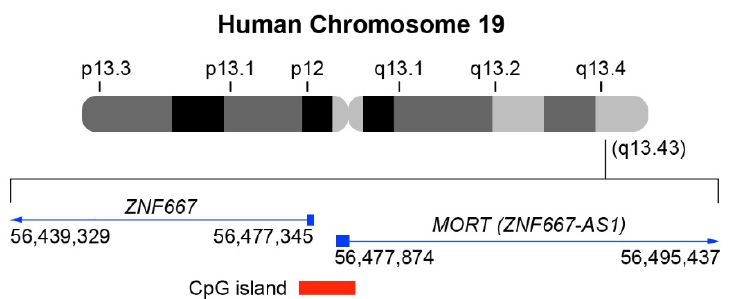
Figure 1. MORT ( ZNF667-AS1 ) and ZNF667 genomic location. MORT ( ZNF667-AS1 ) and ZNF667 are head-to-head antisense-sense strands. MORT ( ZNF667-AS1 ) is also located in 19q13.43 (GRCh38p13 database, chr19: 56,477,874-56,495,437; NCBI: NR_036521.1). ZNF667 is also located in 19q13.43 (GRCh38p13 database, chr19: 56,439,329-56,477,345; NCBI: